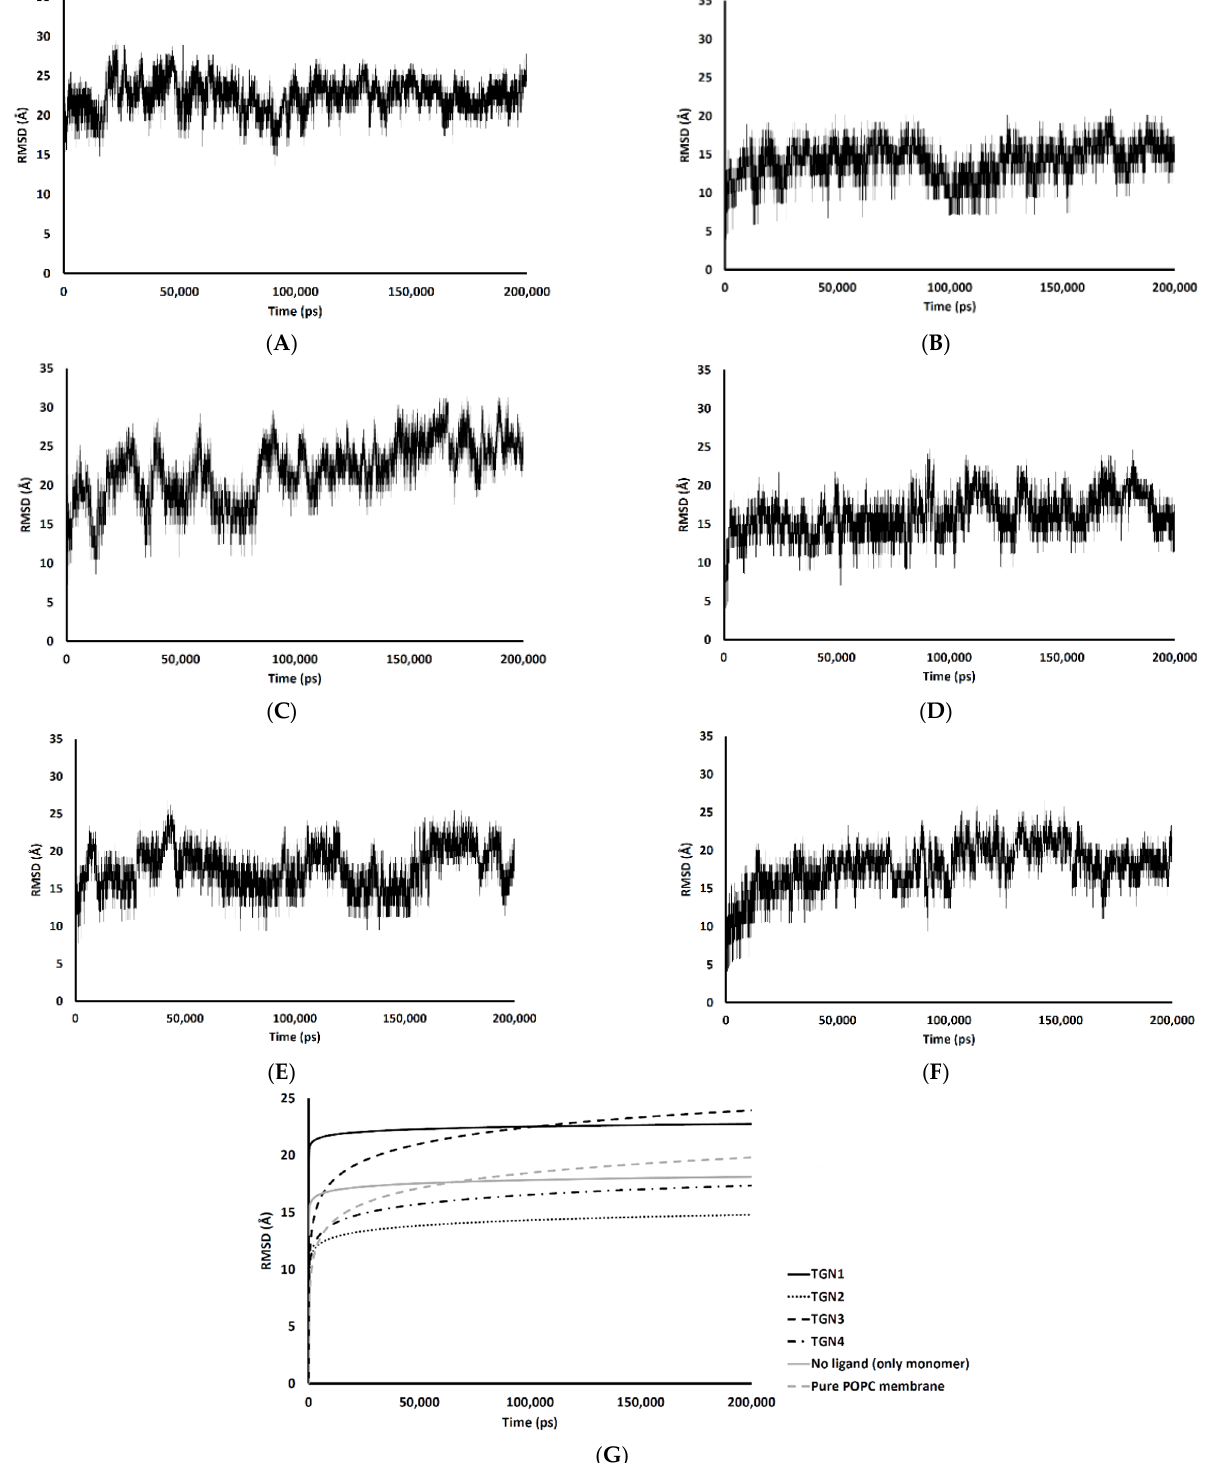
Figure 7. RMSD values of the membrane coordinates of ( A ) TGN1, ( B ) TGN2, ( C ) TGN3, ( D ) TGN4, ( E ) no ligand (only monomer), and ( F ) pure POPC membrane models; ( G ) the logarithmic nonlinearity of RMSD on the ps timescale of all models during the 200,000 ps